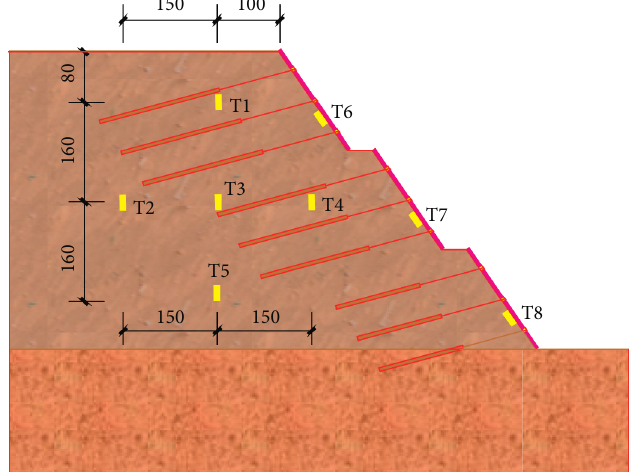
Figure 4: Arrangement of Earth pressure sensors (unit: mm).